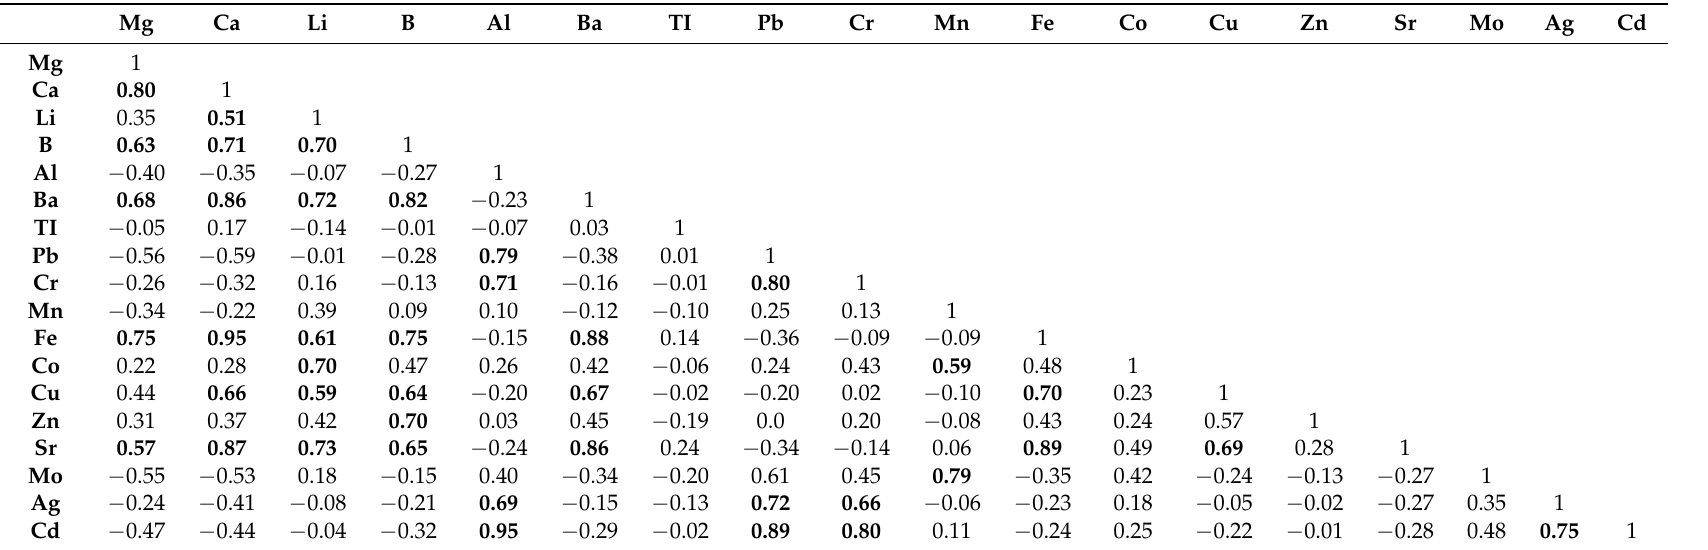
Bold values indicate strong positive correlation (r 2 ≥ 0.50) between